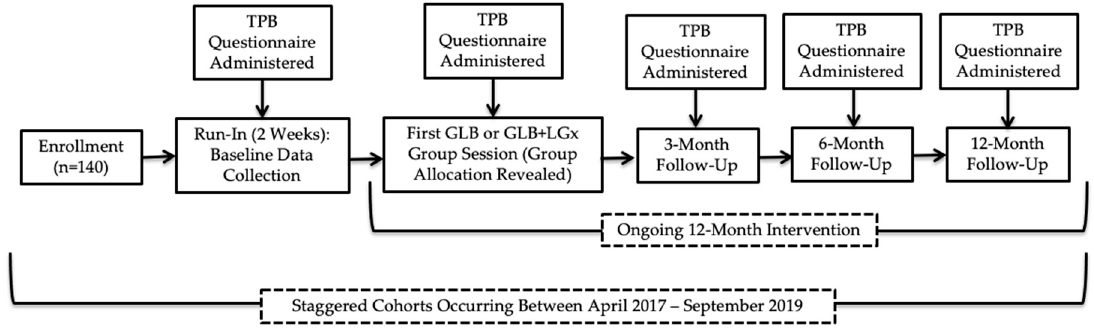
Figure 1. Flow of study design. TPB: Theory of Planned Behaviour; GLB: Group Lifestyle Balance™; LGx: lifestyle genomics.